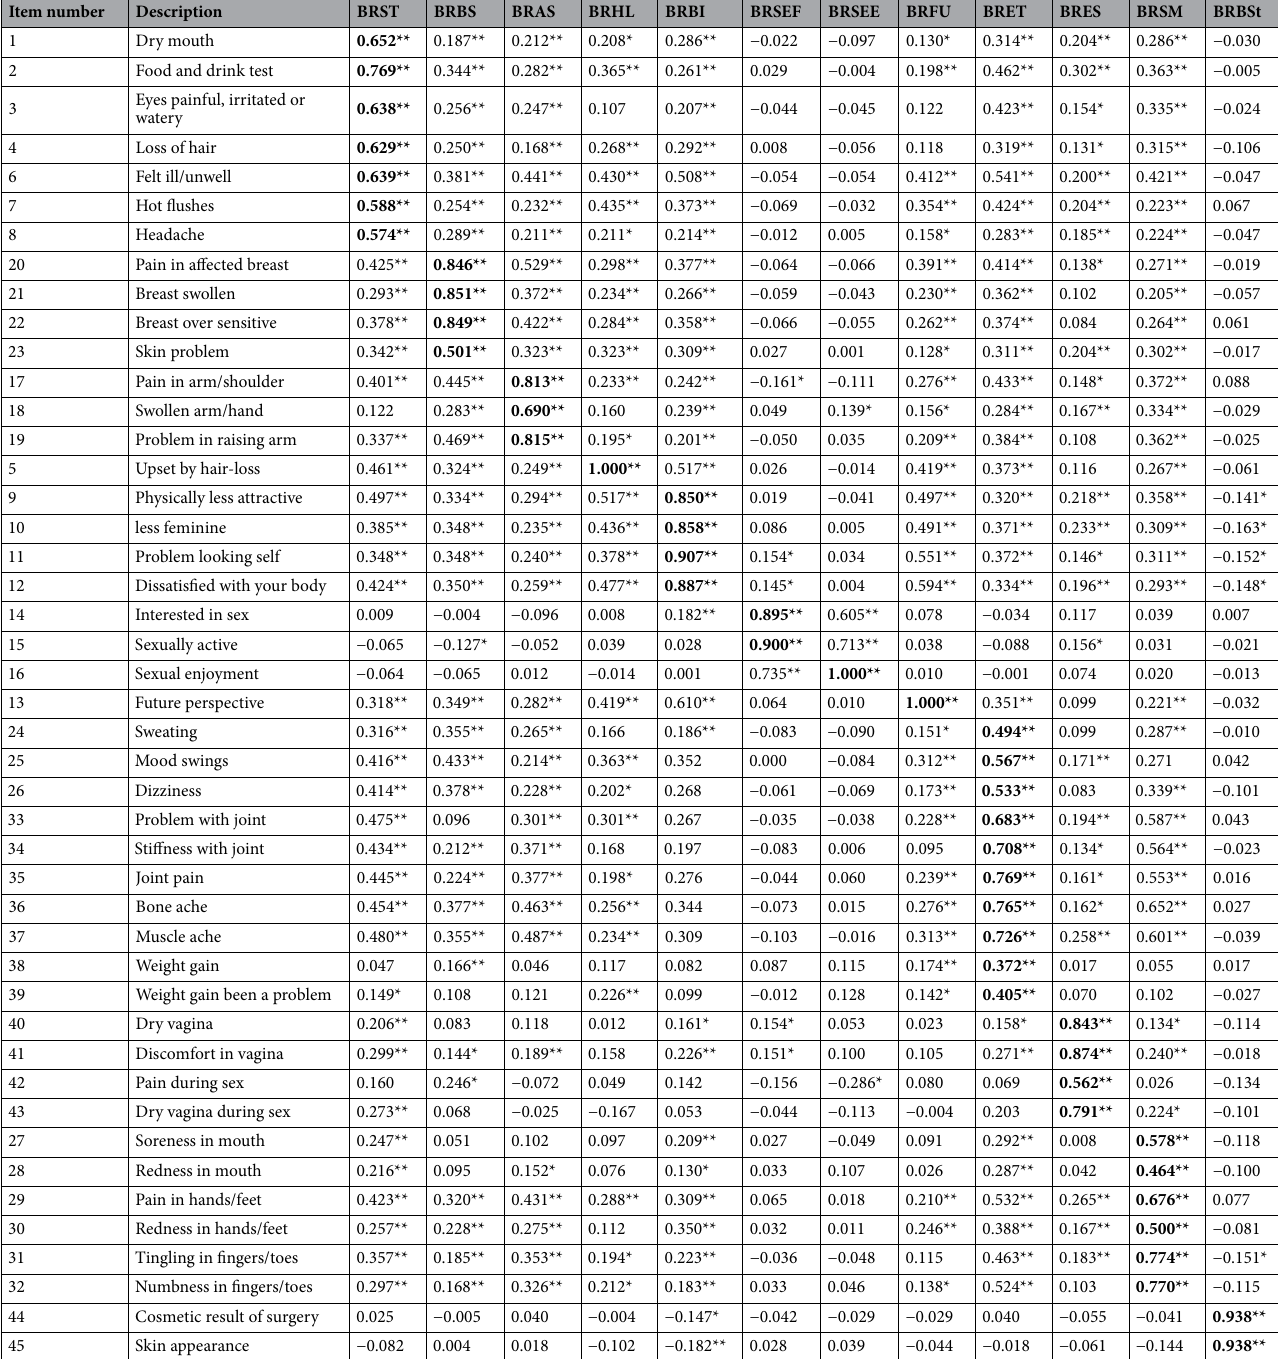
Table 3. Item-scale correlation of EORTC QLQ BR45 Amharic version among breast cancer patients in Ethiopia, 2021. Systemic therapy side effects (BRST); Breast symptoms (BRBS); Arm symptoms (BRAS); upset by hair loss (BRHL); Body image (BRBI); Sexual functioning (BRSEF); Sexual enjoyment (BRSEE); Future perspective (BRFU); Endocrine therapy scale(BRET); Endocrine sexual(BRES); Skin mucosis (BRSM); and Breast satisfaction(BRBSt). Significant values are in